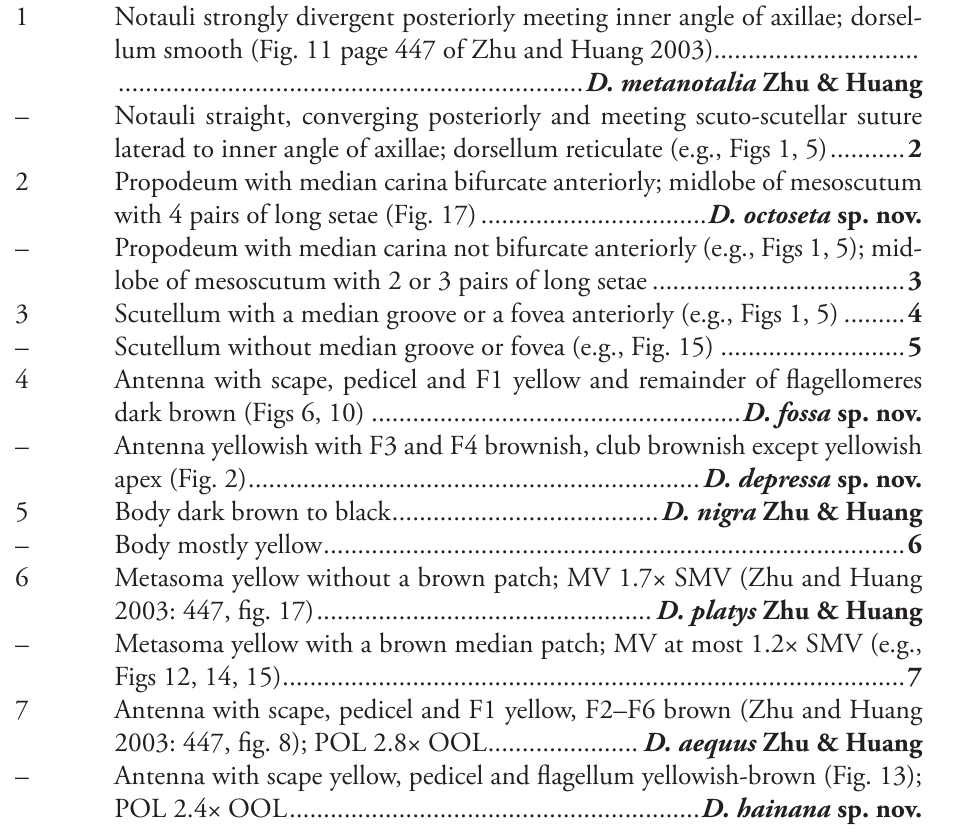
Type material. Holotype , ♀ [NEFU; on card], China, Sichuan Province, Guangyuan City, Qingchuan County, 21 VIII 2015, leg. Ye Chen and Chao Zhang, by sweeping. Paratypes : 2 ♀ [on slides], China, Liaoning Province, Anshan City, Tiedong District, Gudaoguan, 19–21 VI 2015, leg. Yan Gao and Hui Geng, by yellow pan